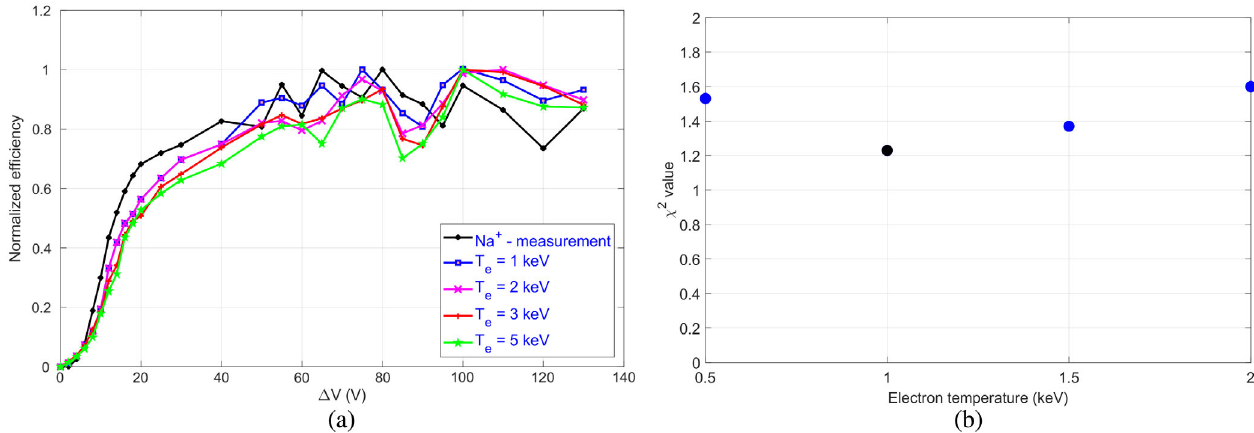
FIG. 9. (a) Comparison of simulated and experimental Na 1 þ Δ V curves acquired from T sweep. The minimum χ 2 value (optimum value of T